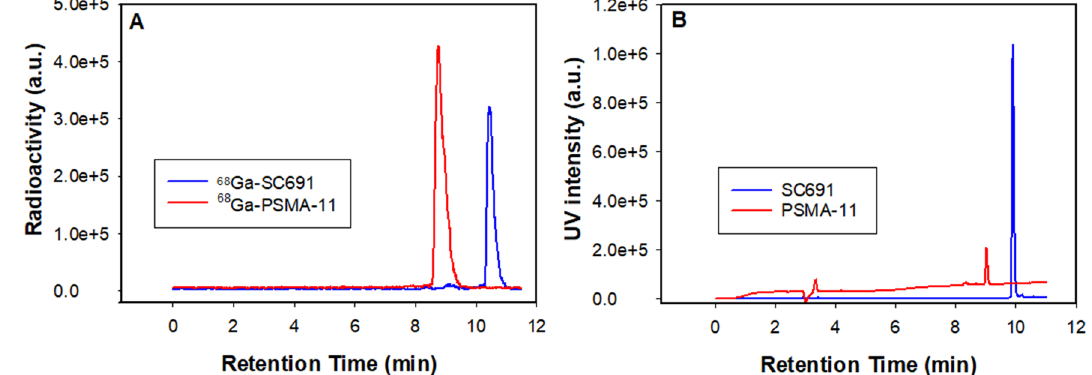
Figure 2. HPLC chromatograms of 68 Ga-PSMA-11 (red line) and 68 Ga-SC691 (blue line) ( A ) and PSMA-11 (red line) and SC691 (blue line) ( B